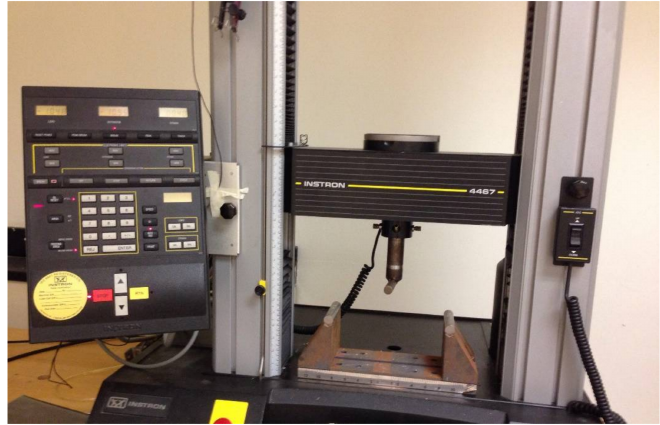
Figure 5. Flexural Test